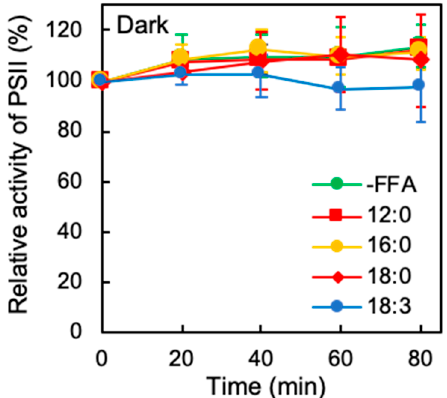
Figure 2. Effect of FFA on PSII activity in the dark. Synechocystis cells were incubated at 32 °C in the dark, with ambient aeration, in the absence (-FFA); green circles or presence of 0.1 mM lauric acid (12:0); red squares, palmitic acid (16:0); yellow circles, stearic acid (18:0); red diamonds, and α -linolenic acid (18:3); blue circles. The activity of PSII of the cells was measured at 32 °C in terms of the evolution of oxygen in the presence of 1 mM 1,4-benzoquinone and 1 mM K 3 Fe(CN) 6 . Values are means ± S.D. (bars) of results from three independent experiments.